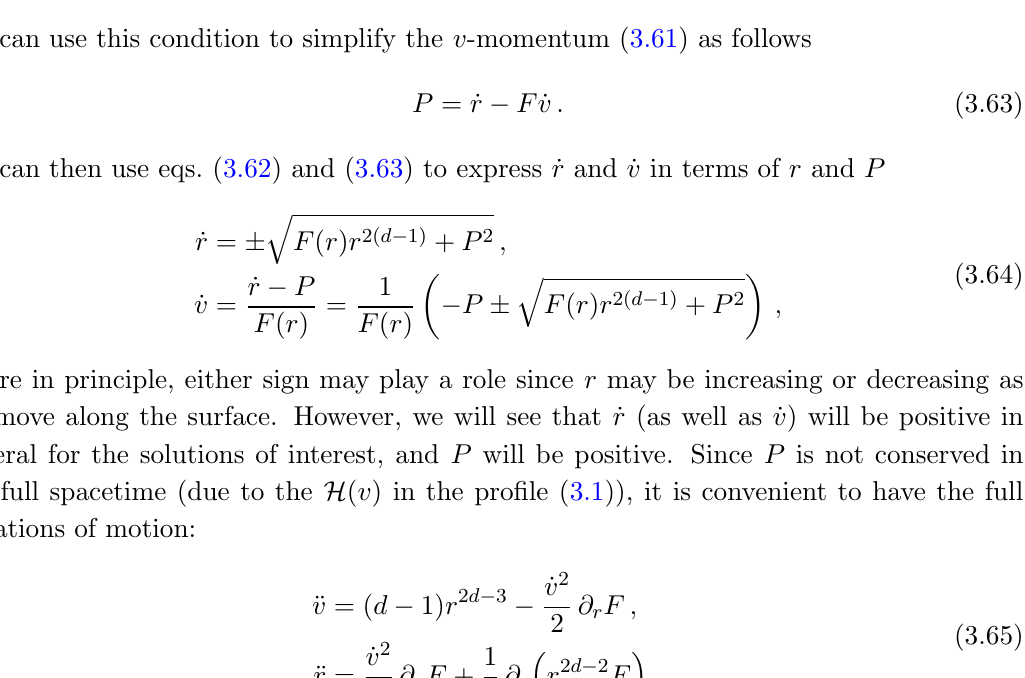
Figure 5 . Penrose-like diagram of maximal volume surfaces at di(cid:11)erent times embedded in the Vaidya AdS spacetime. Constant time slices are indicated by thin dashed gray lines and the maximal volume surfaces asymptote them near the boundary. The event horizon extends past the shell, as we have indicated by a thick dashed gray line. Since the momentum (3.61) of the surfaces is positive, they evolve towards decreasing time outside the horizon. Surfaces lie on constant time slices in the vacuum part of spacetime to avoid a conical singularity at r =